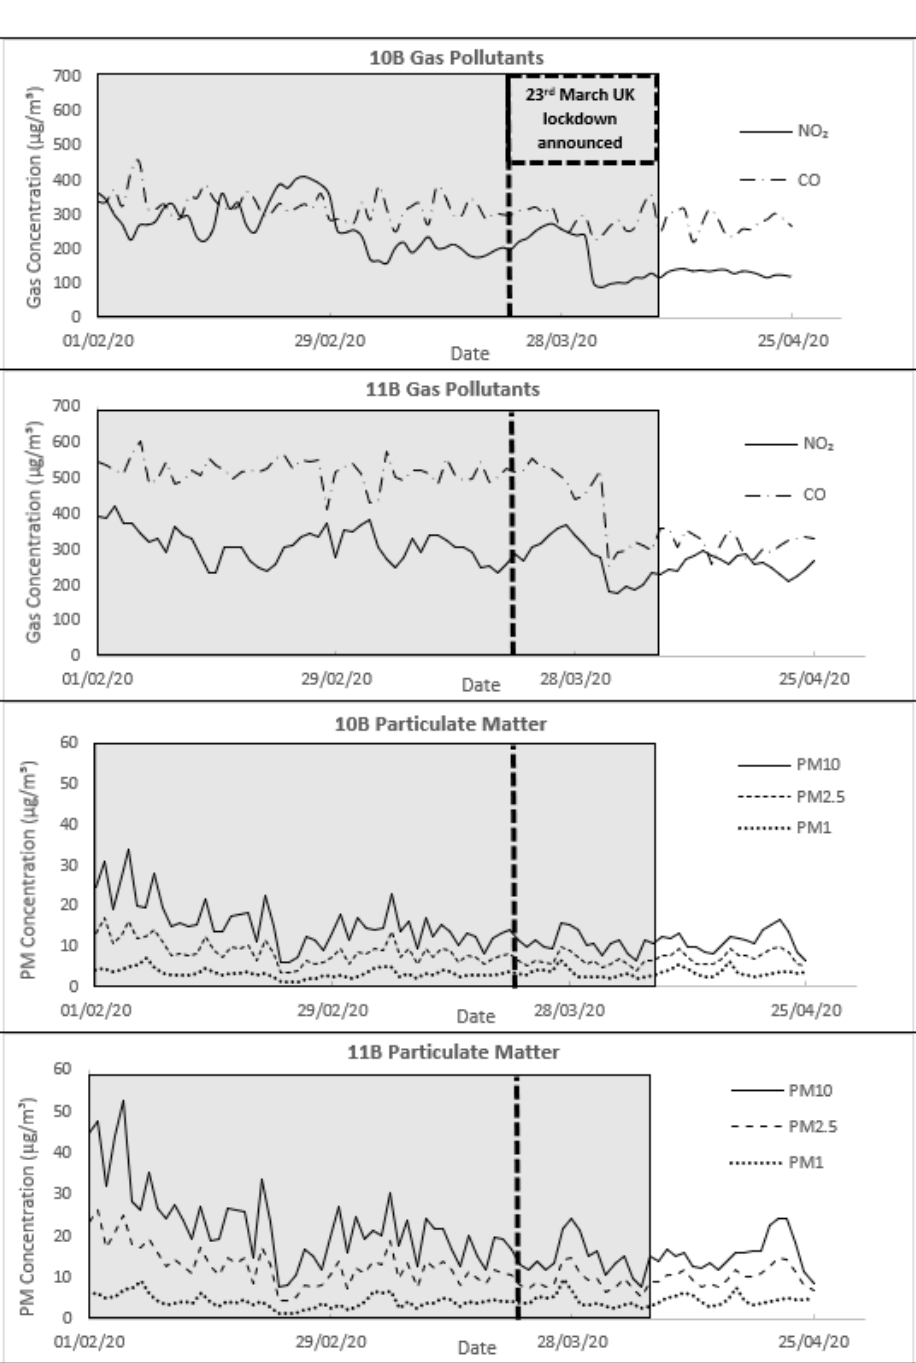
Figure 3. Time series of 24 h gaseous pollutants (NO 2 and CO) and particulate matter (PM 1 , PM 2.5 , and PM 10 ) concentrations between 1 February and 25 April 2020. The 68-day analysis period from 1 February to 8 April is marked in a grey shaded box. Note differing concentration scales for gaseous pollutants and PM.